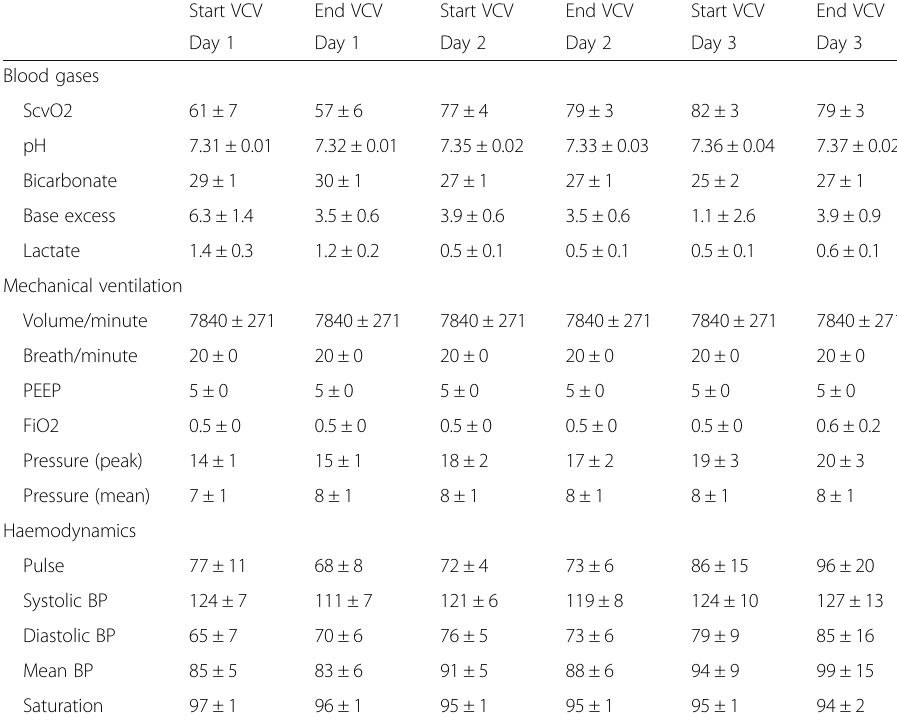
Table 1 Hemodynamics parameters at the start and at the end of the daily measurements during volume-controlled ventilation